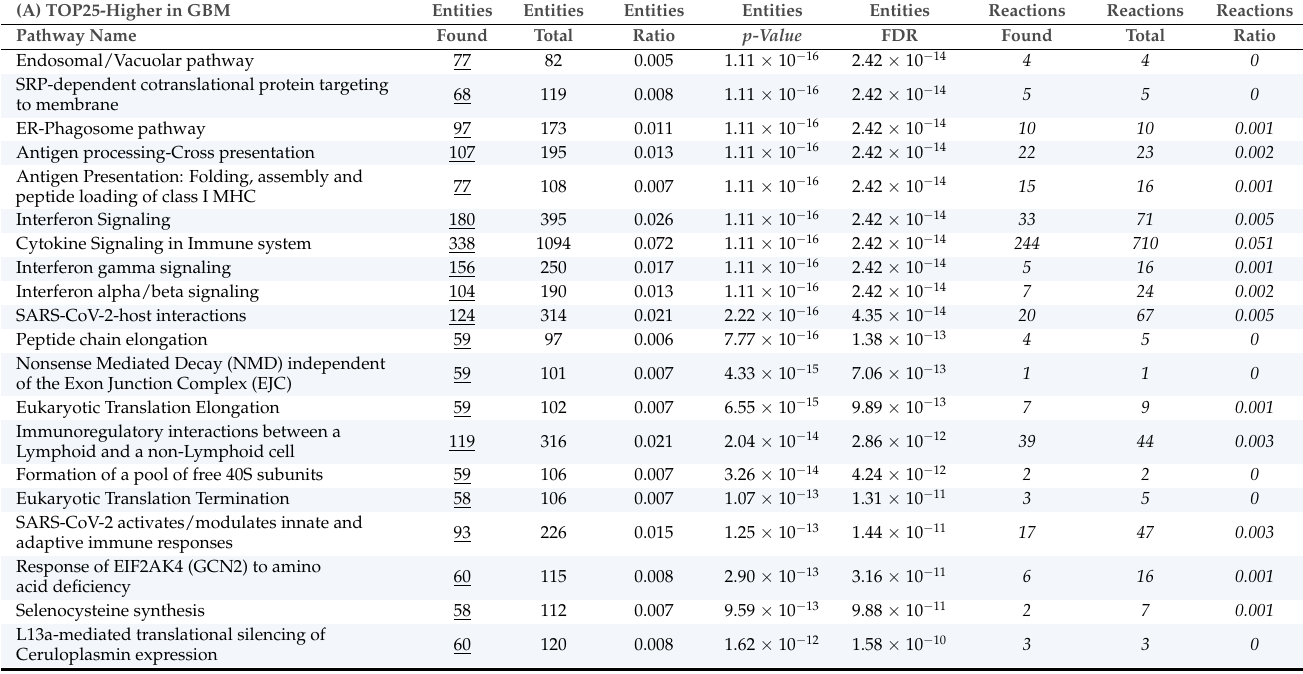
Table 2. ( A ) Upper table: top 25 pathways derived from the reactome analysis of genes overex- pressed in GBM, using the OncoDB data set. ( B ) Bottom table: likewise for genes overexpressed in normal